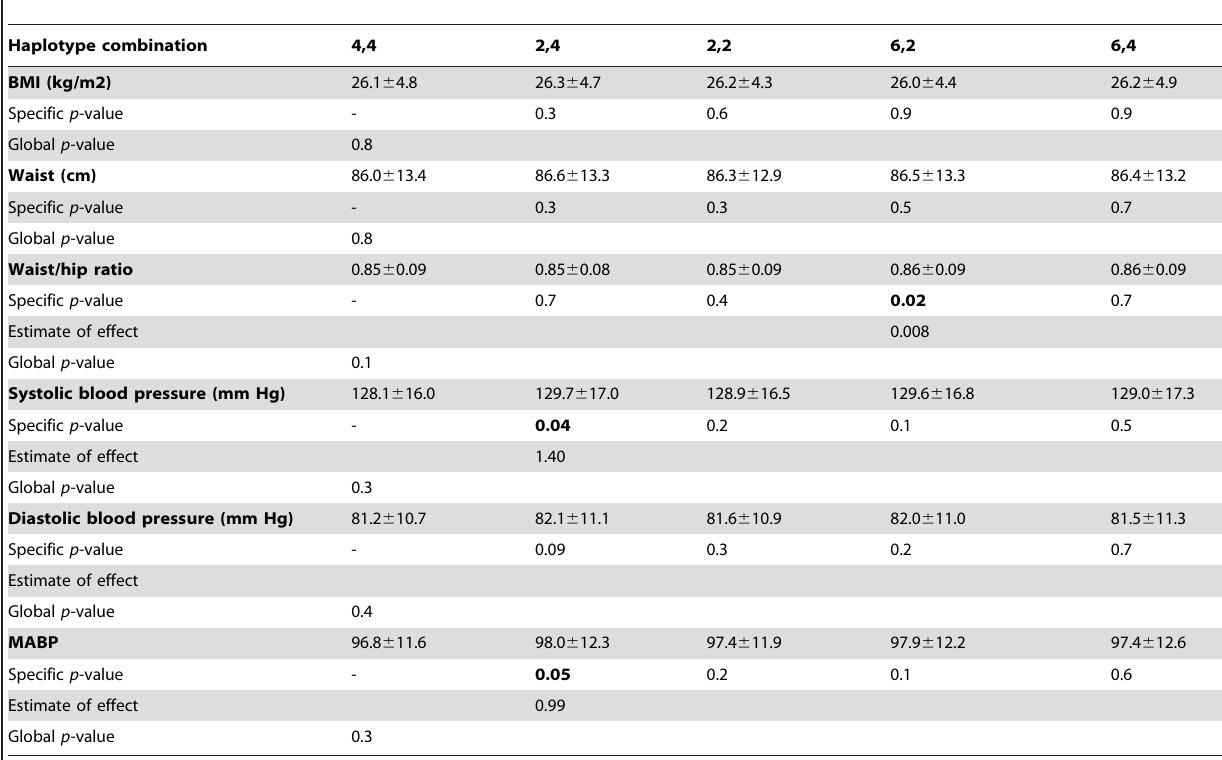
Table 2. Comparison between ADRB2 haplotype combinations and body composition and blood pressure among 4,885 and 4,566 Danish individuals,